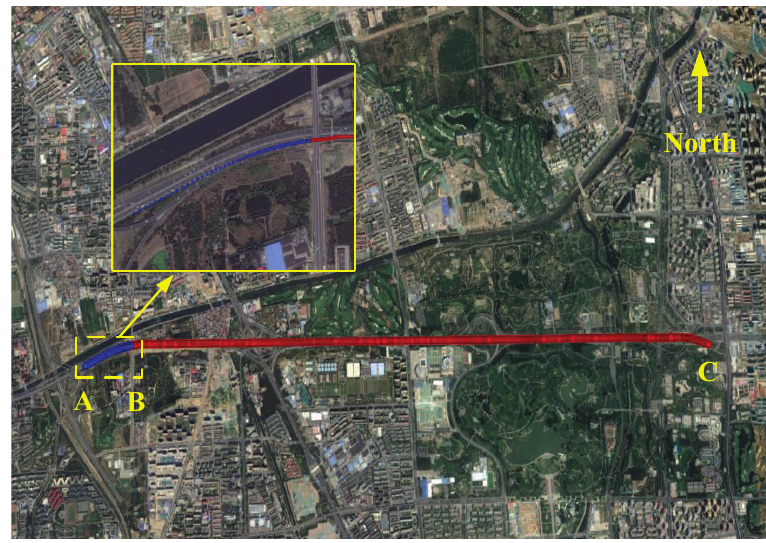
Figure 13. Trajectory of the van test.